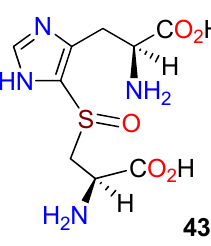
Figure 16. Structures of selenoneine ( 12 ) and selenocysteine ( 52 ).